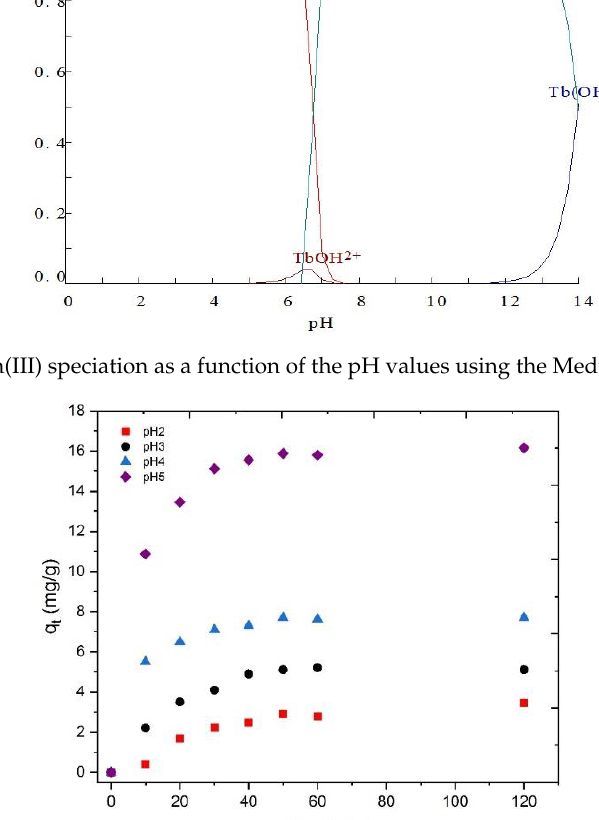
Figure 9. Influence of the solution pH in Tb(III) adsorbed onto the CRS at the different times tested.